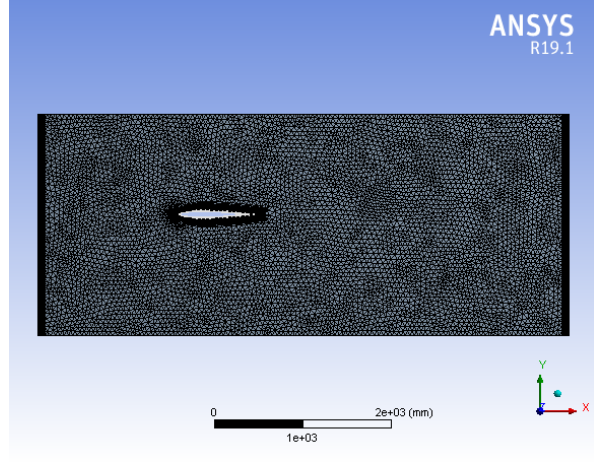
Figure 2. 2-D airfoil generated with point NACA 0012 at a 0 ◦ blade twist